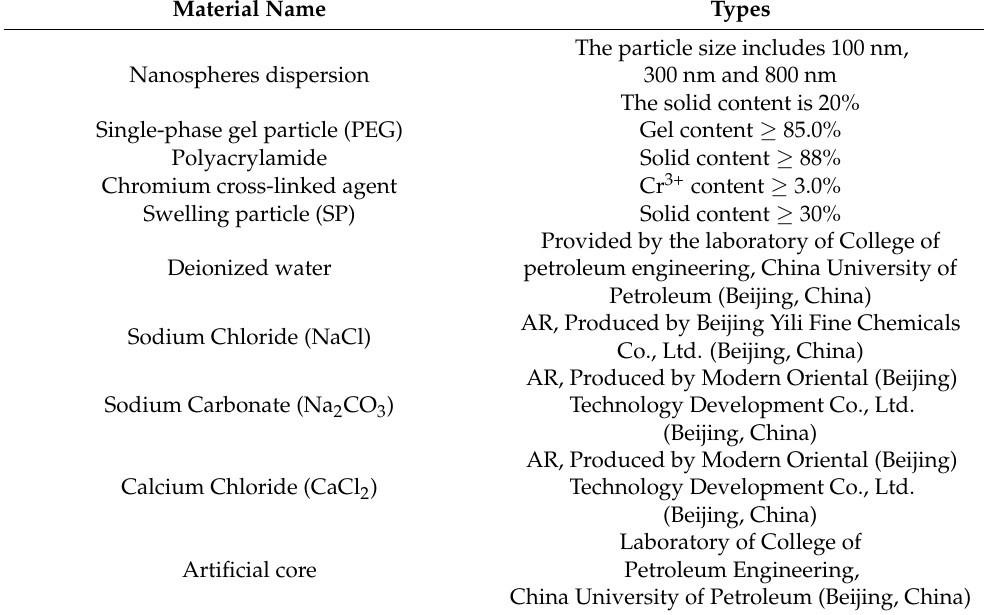
Table 17. Information on experimental